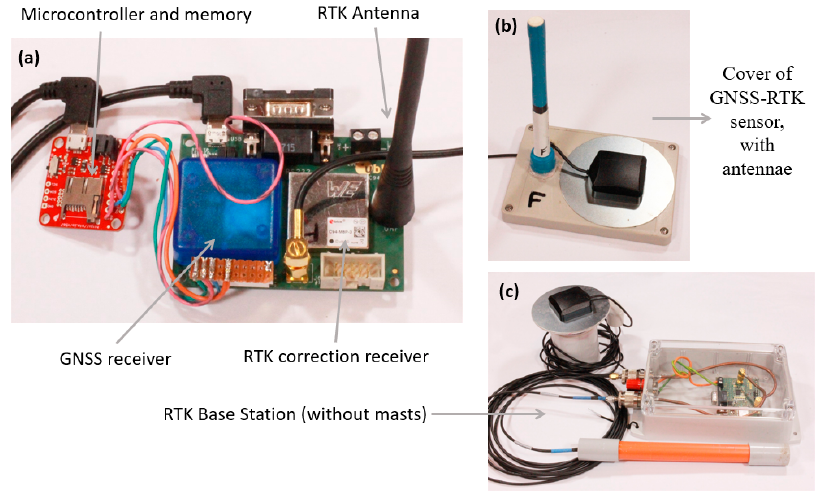
Figure 1. The system hardware components consisting of: ( a ) rover electronics showing the data logger, and Real-Time-Kinematic (RTK) module, ( b ) the rover packaging showing the Global Navigation Satellite System (GNSS)) and RTK correction antennae, and ( c ) the base station with the electronics and antennae (without their masts).